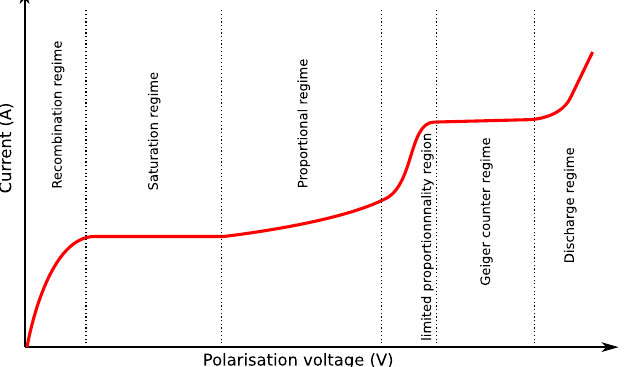
Fig. 1. Operation regimes of fission chambers.